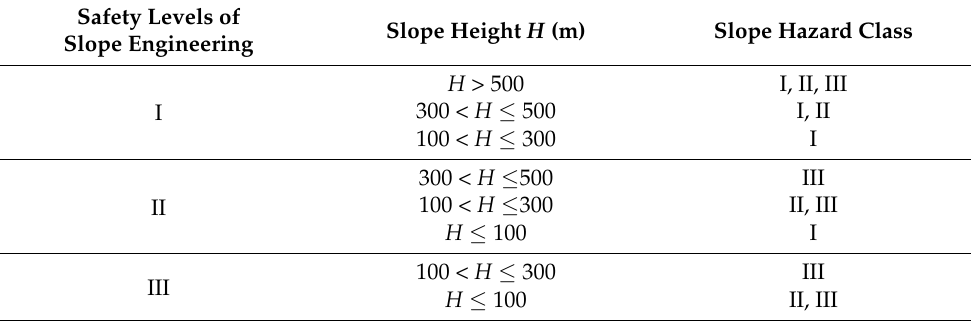
Table 3. Classification of safety